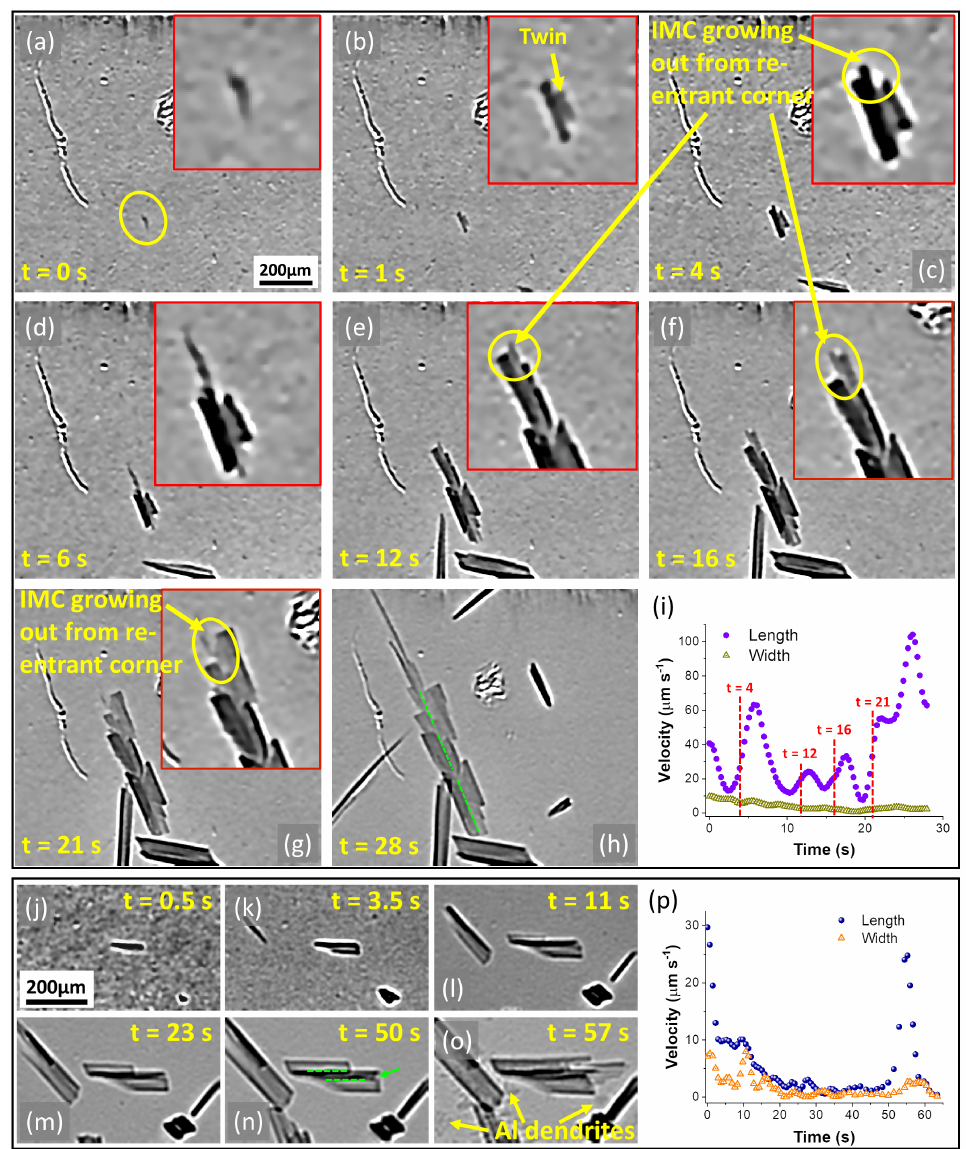
Figure 8. ( a – h ) A radiograph sequence of growth of an elongated Al 13 Fe 4 crystal at 0.5Ks − 1 , showing repeated microscopic twins and re-entrant corners. t = 0 s was set at the beginning of the size measurement. Inset images with red frames provide a magnified view. The green dashed lines in ( h ) highlight the boundaries between the microscopic twins. ( i ) Corresponding time resolved growth velocities along the length and width. The time instants when a new plate appeared at the re-entrant corners ( t = 4 s, t = 12 s, t = 16 s and t = 21 s) are labelled. ( j – o ) A radiograph sequence showing the growth of an Al 13 Fe 4 crystal whose preferential growth was constrained by surrounding IMCs. The green dashed lines in ( n ) highlight the boundaries between layered twins, and the green arrow denotes a re-entrant corner. ( p ) Corresponding time resolved growth velocities